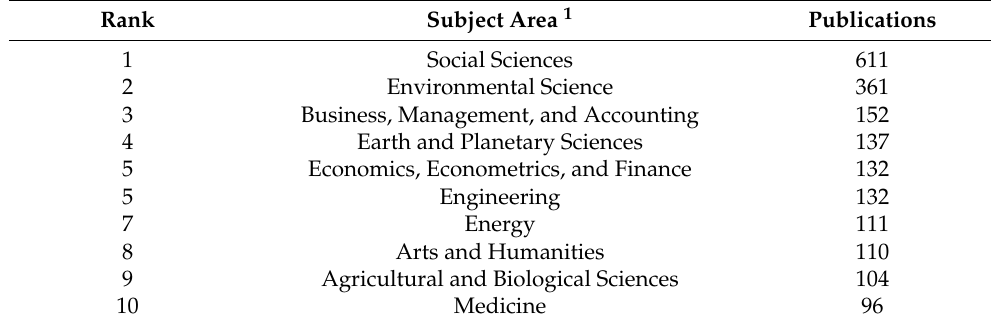
Table 4. Top 10 categories of subject areas.